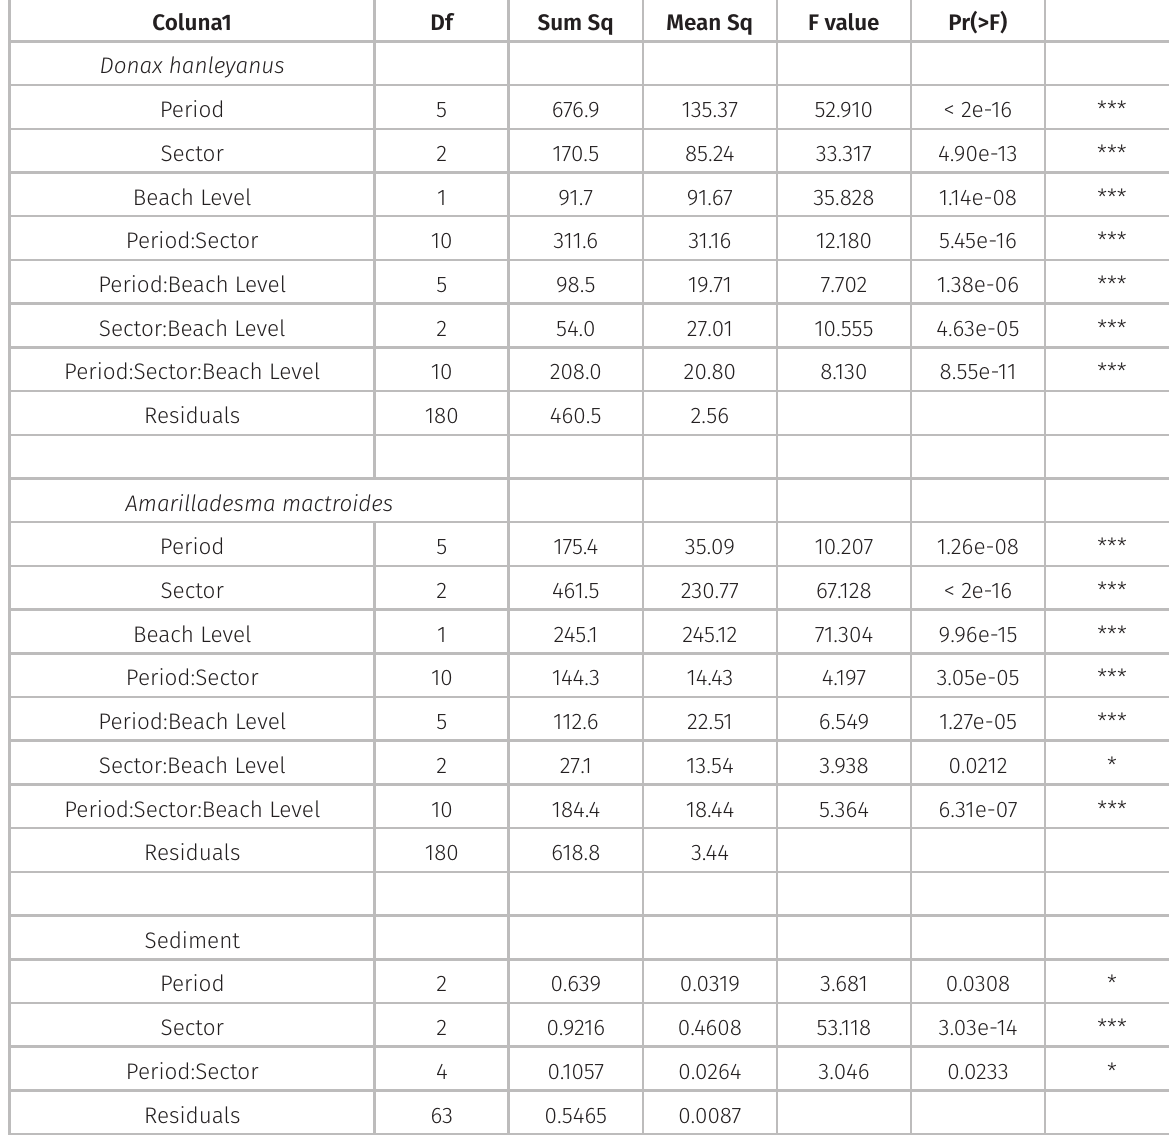
Table I. Summary of ANOVAs showing possible spatio-temporal significant differences for the densities of D. hanleyanus , A. mactroides and for the averages of grain size. Coluna1 Df Sum Sq Mean Sq F value